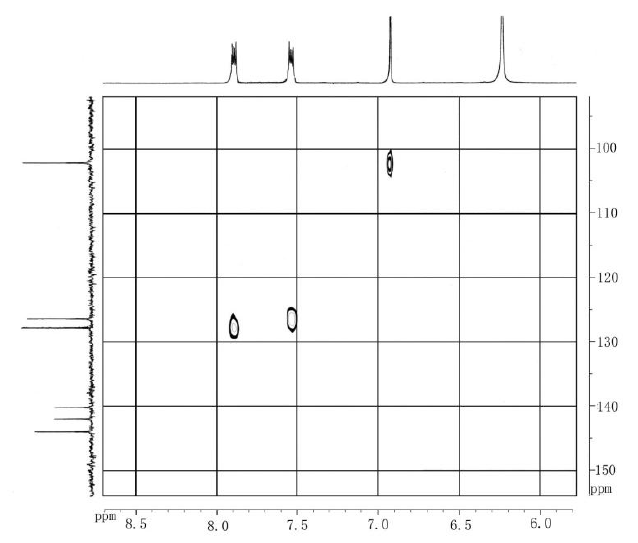
Figure 4. HSQC spectrum of the product in